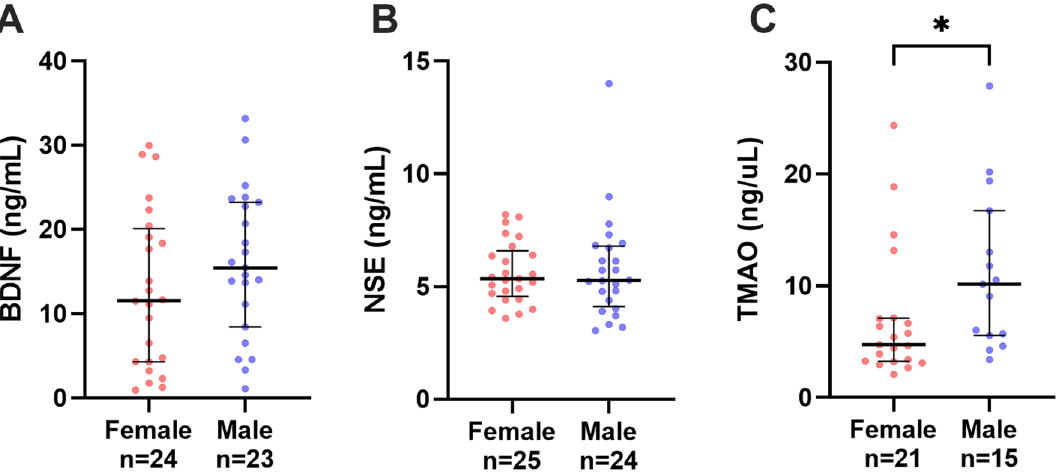
Figure 3. Sex-related differences in haemodialysis patients with self-assessed depression and serum concentrations of biomarkers; ( A ) brain-derived neurotrophic factor (BDNF), ( B ) neuron-specific enolase (NSE), ( C ) trimethylamine N-oxide (TMAO). The number of samples (n) that each analyte was detected in is noted for each group. Data presented at median and interquartile range when appropriate. Statistical significance, * p < 0.05.